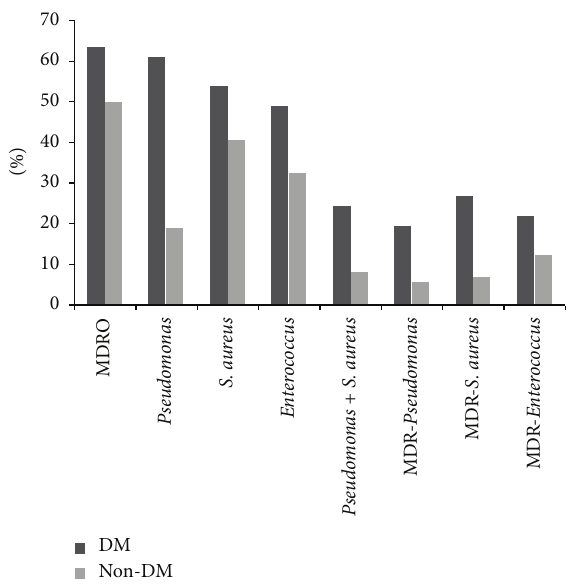
Figure 2: Percent of DM and non-DM patients with MDR- and non-MDR- Pseudomonas , - S. aureus, and - Enterococcus wound infections.